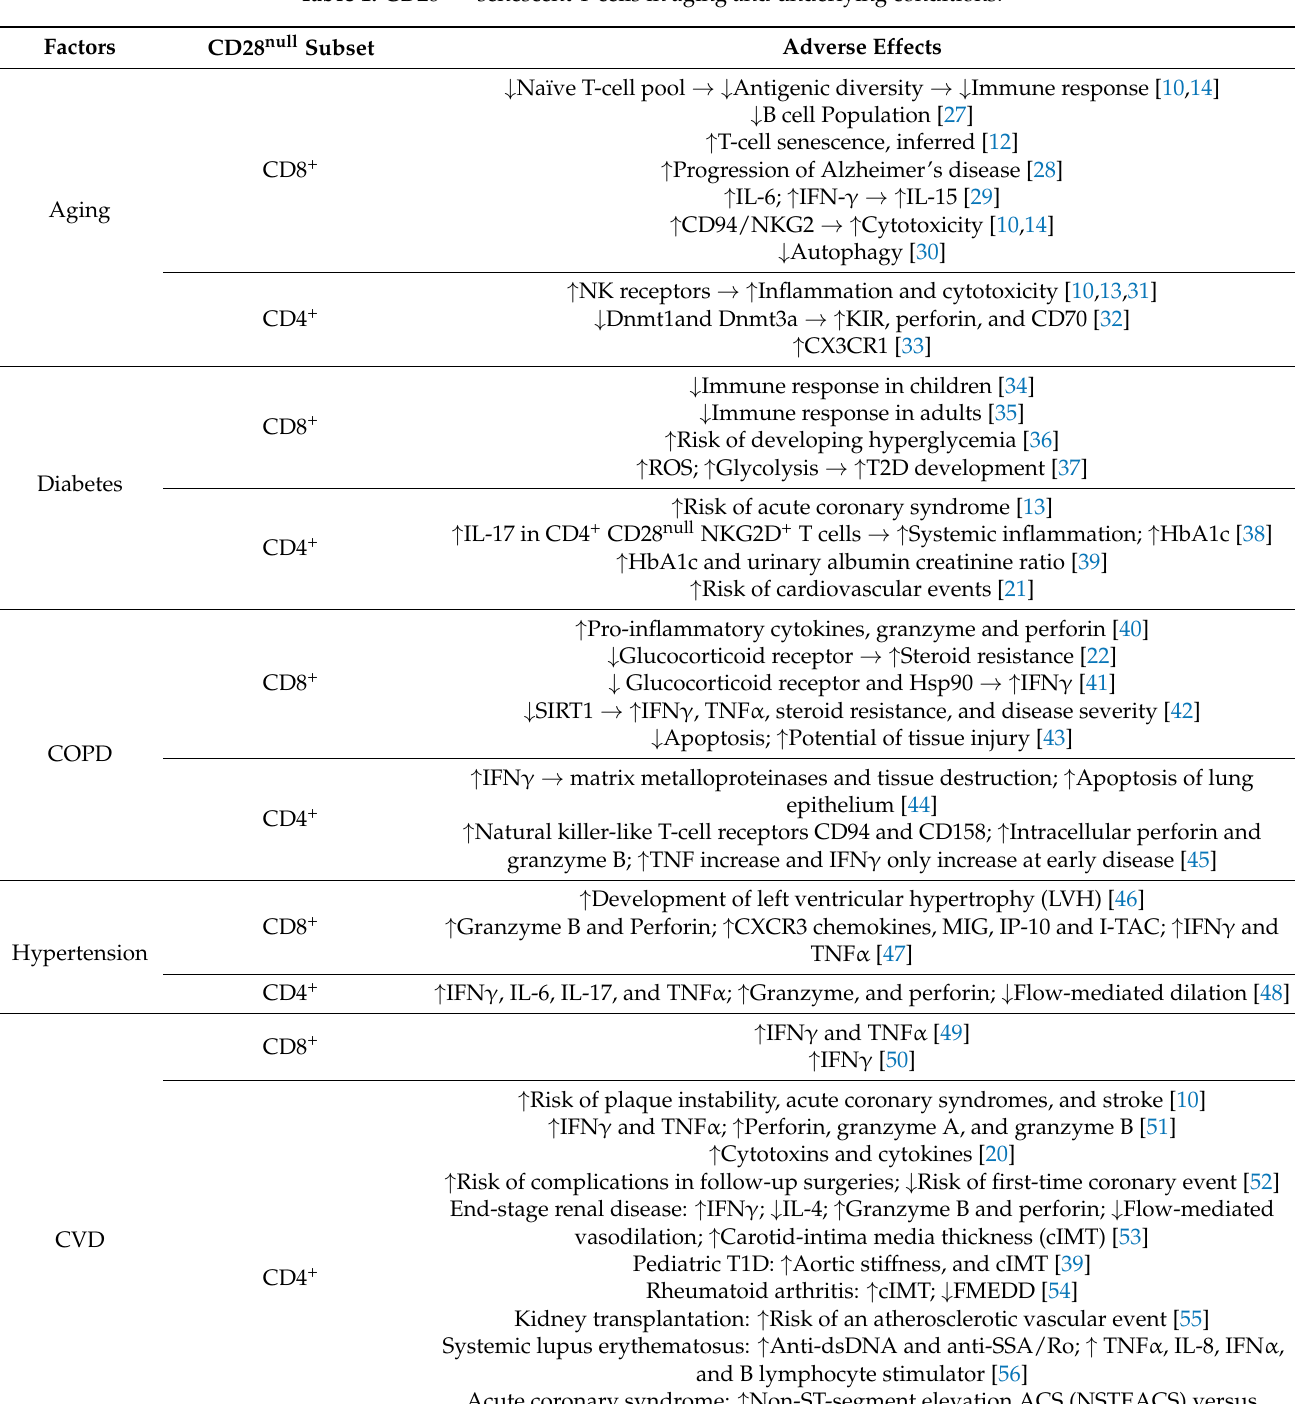
Table 1. CD28 null senescent T-cells in aging and underlying